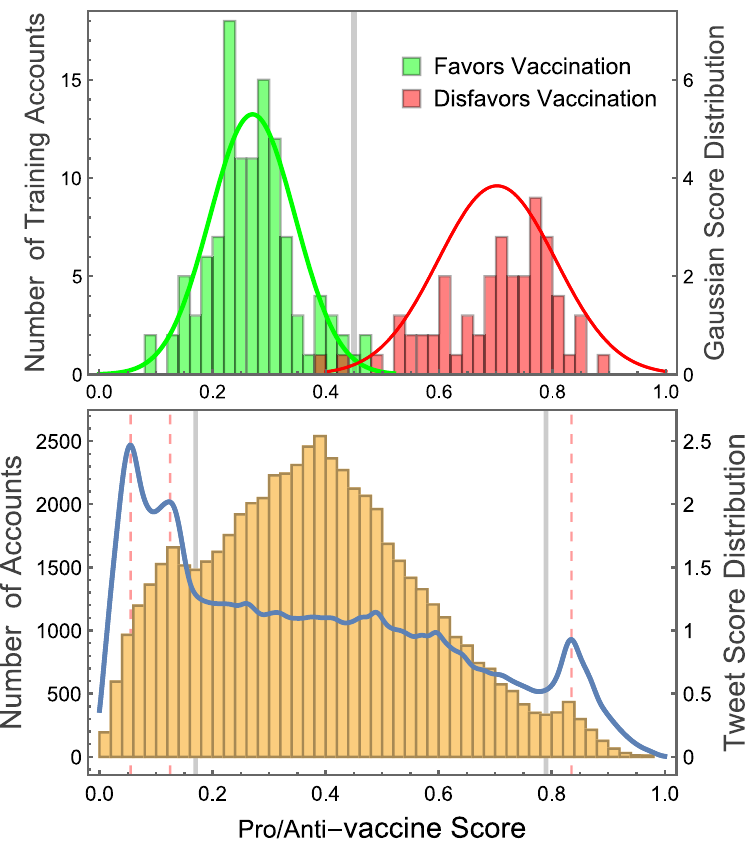
Figure 1. Score distributions and definition of account categories (pro-vaccine, promoter, inhibitor, anti- vaccine). Top: Histograms of pro/anti-vaccine scores of the two training sets (one favoring and one disfavoring vaccination), and corresponding Gaussian distributions, used to estimate the boundary between accounts that favor or disfavor vaccination (vertical gray line). Bottom: Histogram of the scores of all accounts (orange bins of width 0.02) and distribution of individual tweet scores (blue curve). The histogram maximum corresponds to the score of the most common views. The local maxima at both sides and peaks in the distribution curve (labeled by red dashed lines) match the scores of activist messages, since these use repetitive language that results in similar values. The histogram’s local minima are thus used to define the boundaries between pro/anti- vaccine activist and moderate accounts (vertical gray